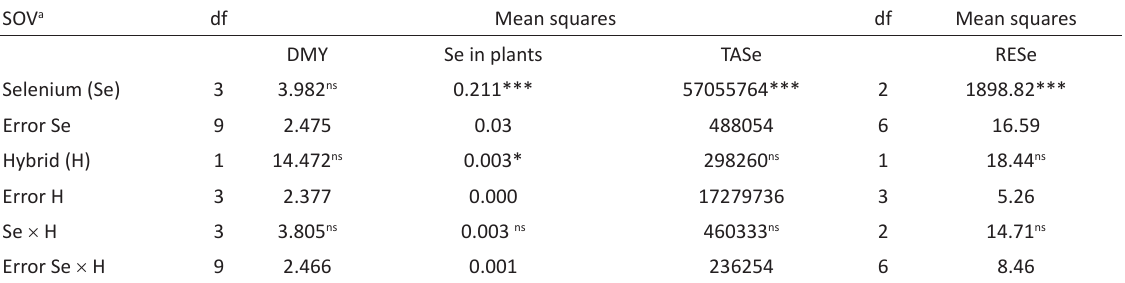
Table 2. Analysis variance (showing mean squares) for the effects of the experimental treatments on the selenium content and dry matter yield (DMY) of the maize in 2014 SOV a df Mean squares df Mean squares DMY Se in plants